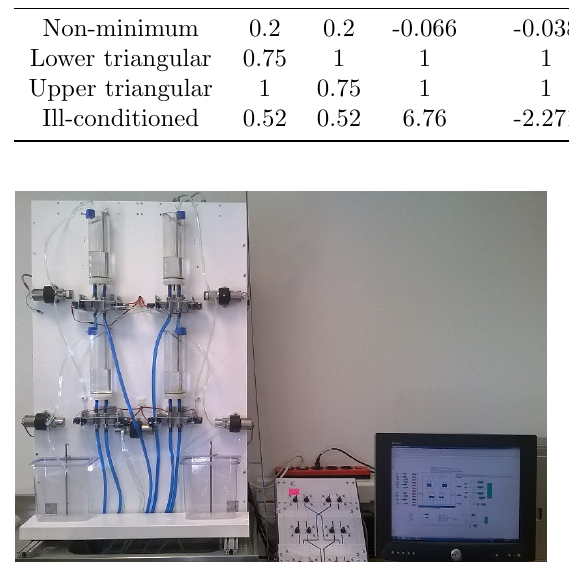
Figure 6: The quadruple tank process in the Control Engineering Group